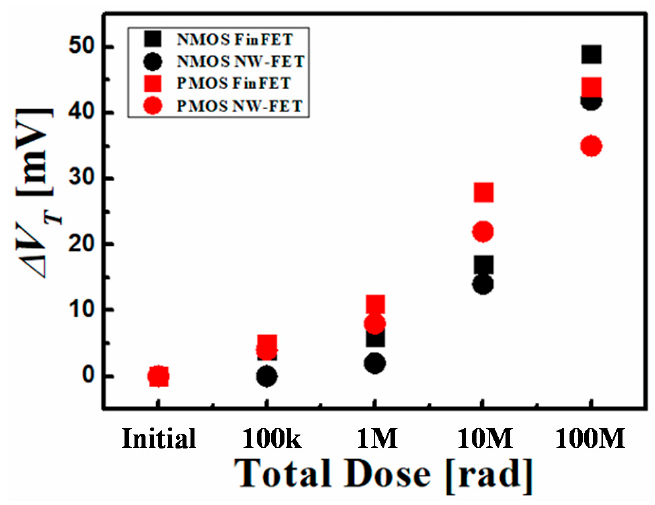
Figure 3. FinFET and NW-FET V T shifts according to the total ionizing dose (TID).